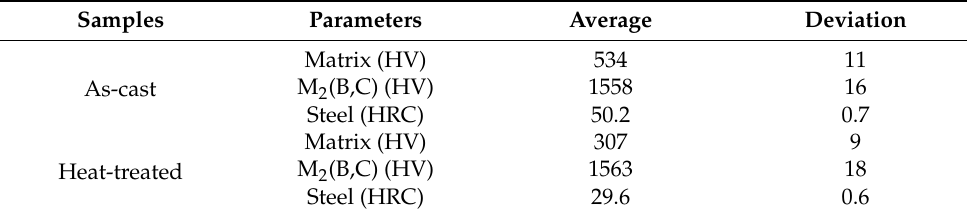
Figure 4. X-ray diffraction spectrums of as-cast ( a ) and heat-treated, ( b ) boron-bearing stainless steel. Table 2. Hardnesses of the microstructures and boron-bearing stainless steel.